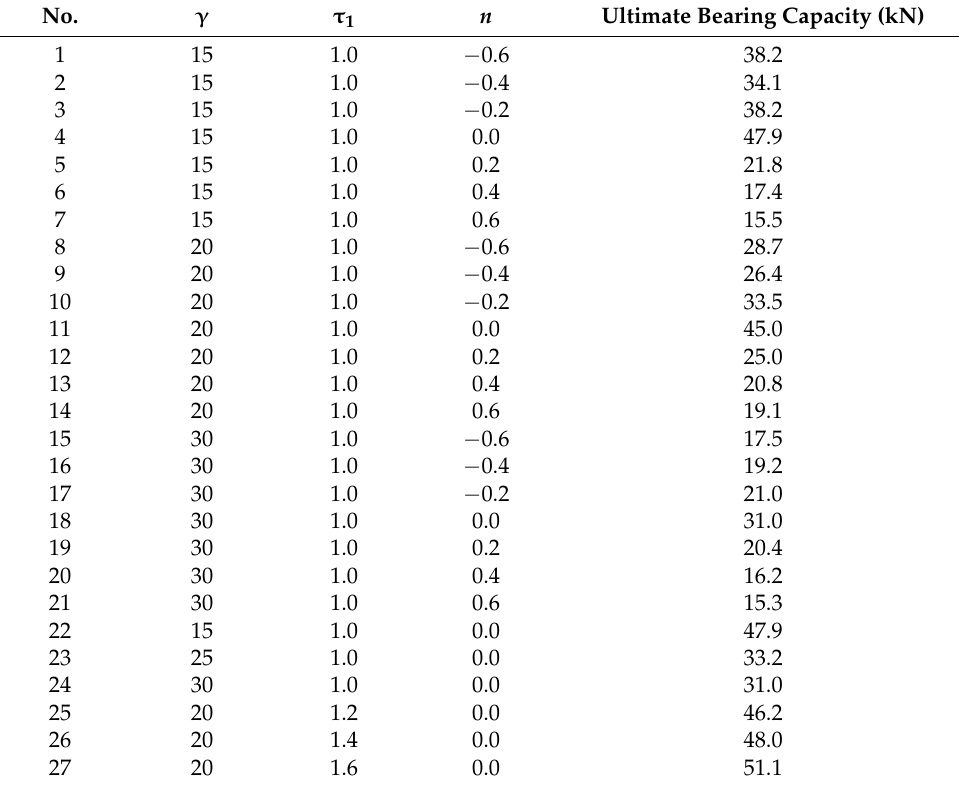
Table 4. Details of the FE models